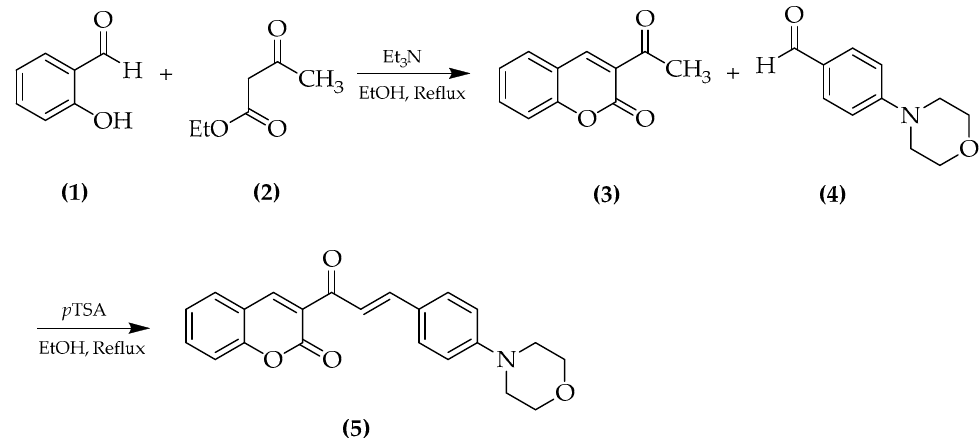
Figure 1. Synthesis pathway of the target molecule.